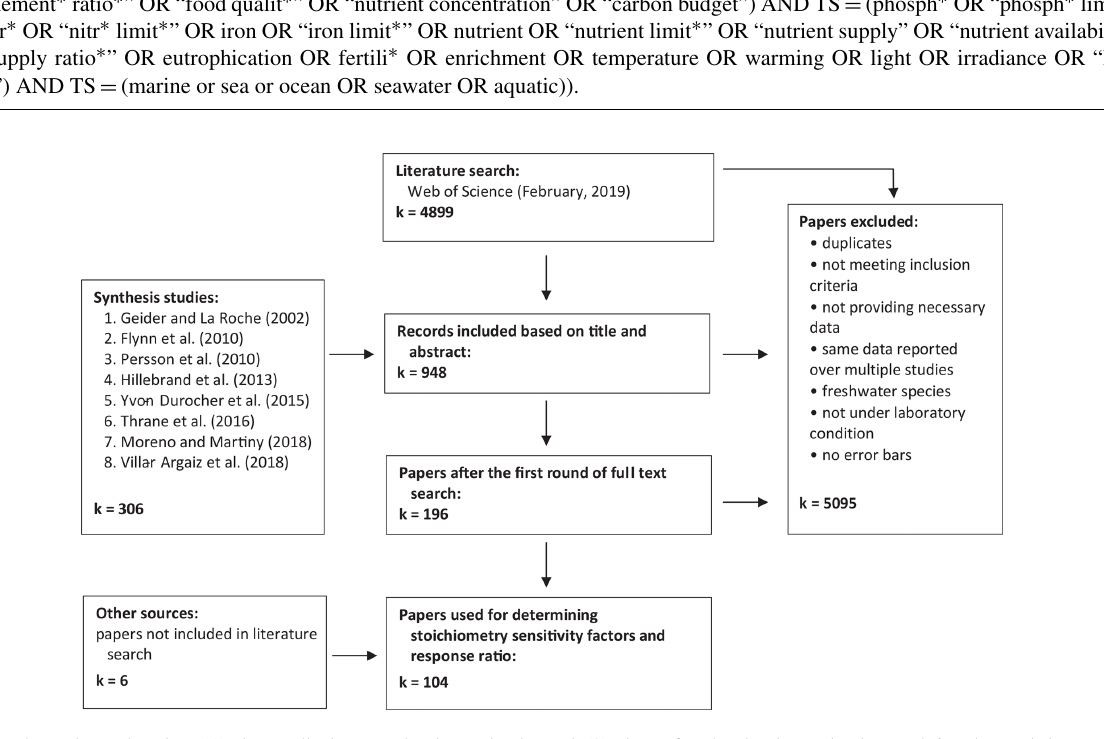
Figure 1. Flow chart showing (1) the preliminary selection criteria and (2) the refined selection criteria used for determining s factors. Numbers ( k values) correspond to the number of journal articles. See Supplement (Sect. S1) for a full list of studies included in the meta-